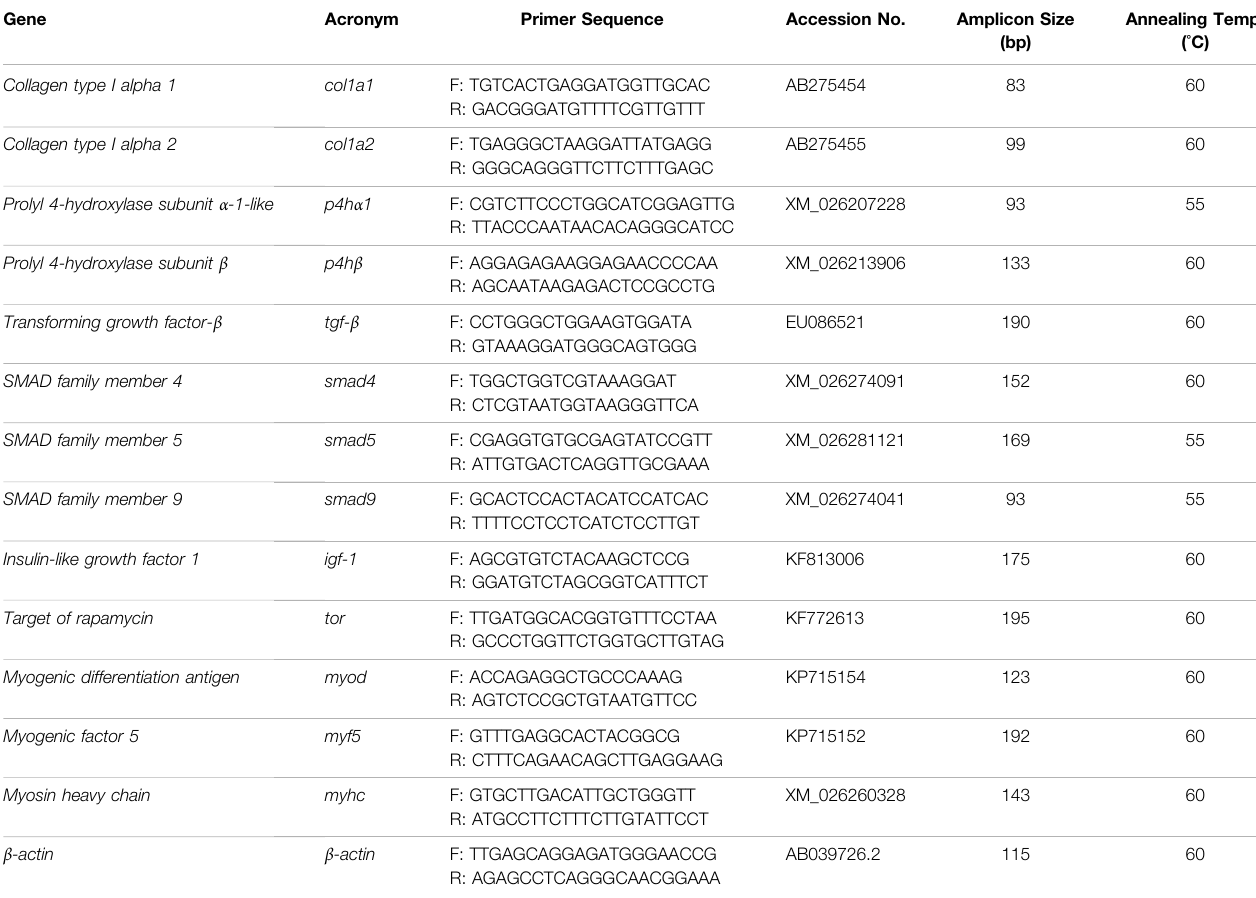
TABLE 3 | Sequences of the primers used for qRT-PCR